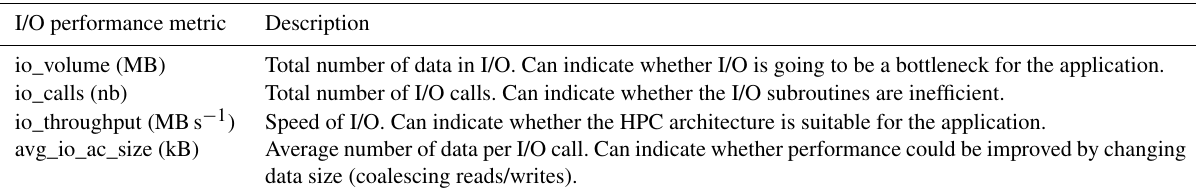
Table B2. Description of performance analysis metrics pertaining to I/O, currently supported by our